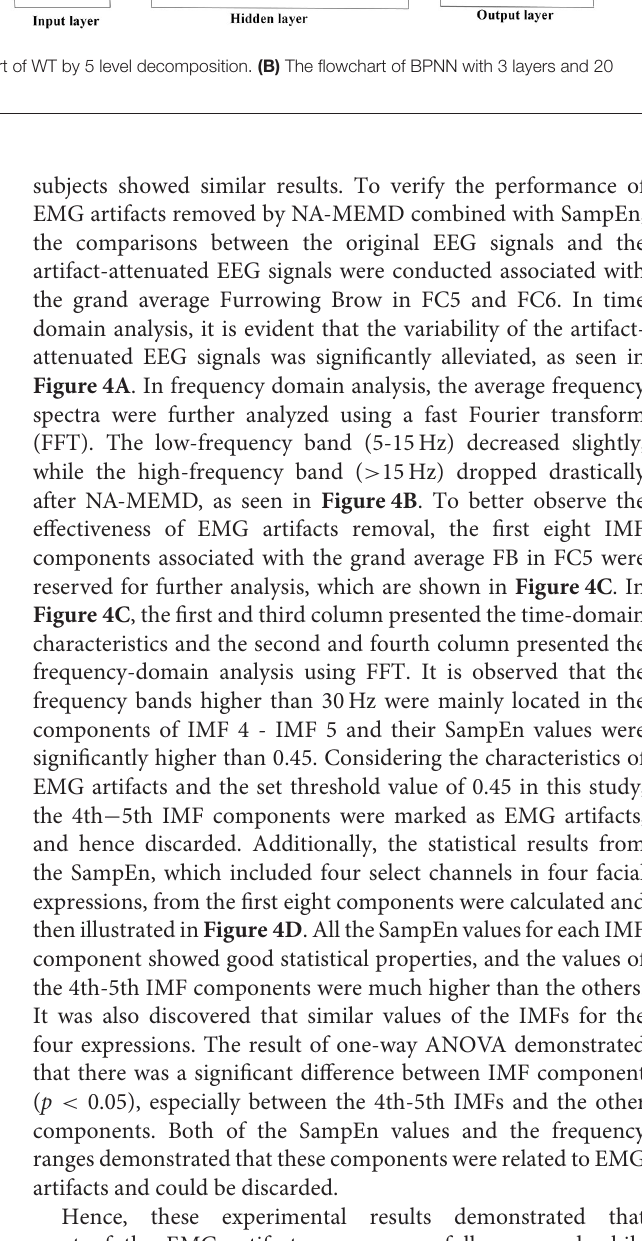
were used to train his/her own classifier. The offline dataset